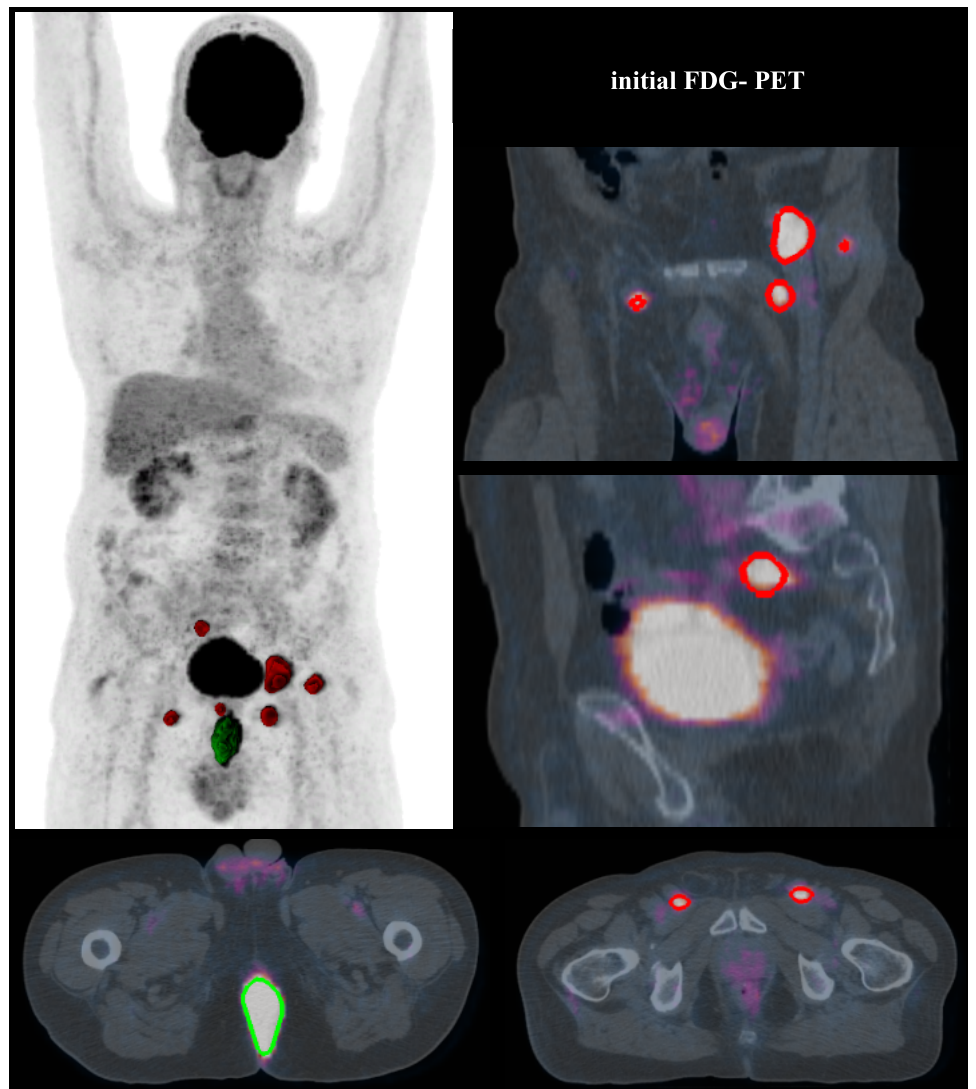
Figure 2. A T4N0 anal SCC was diagnosed at a 71-year-old patient. Initial FDG-PET modified the tumour staging as T4N3 due to an observed extended lymph node involvement (bilateral inguinal, perirectal and external iliac positive nodes). The T-MTV was 70.1 cm 3 (with 35% SUVmax threshold). Imaging showed residual disease three months after the end of treatment, confirmed by pathological results of surgery. (Segmented volumes: for tumour in green, for lymph nodes in red). Table 4. Literature review. Prognostic performances of pretherapeutic FDG-PET in patients with anal SCC cancer.